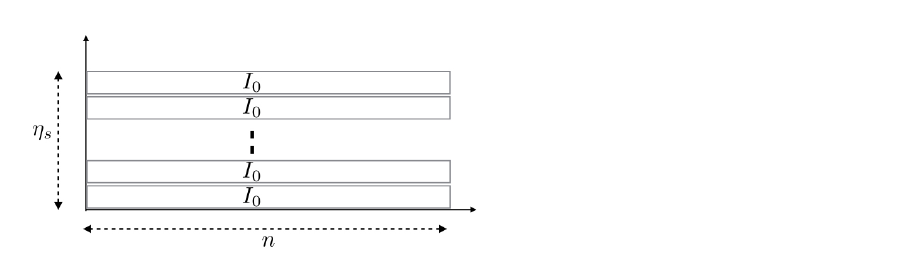
Figure 2. The asymptotic regime is obtained at the limit when n → ∞ . The cell spectral efficiency is kept constant, but the number of packets transmitted simultaneously tends to infinity. Each packet I 0 is spread over n channel uses, and the individual spectral efficiency tends to